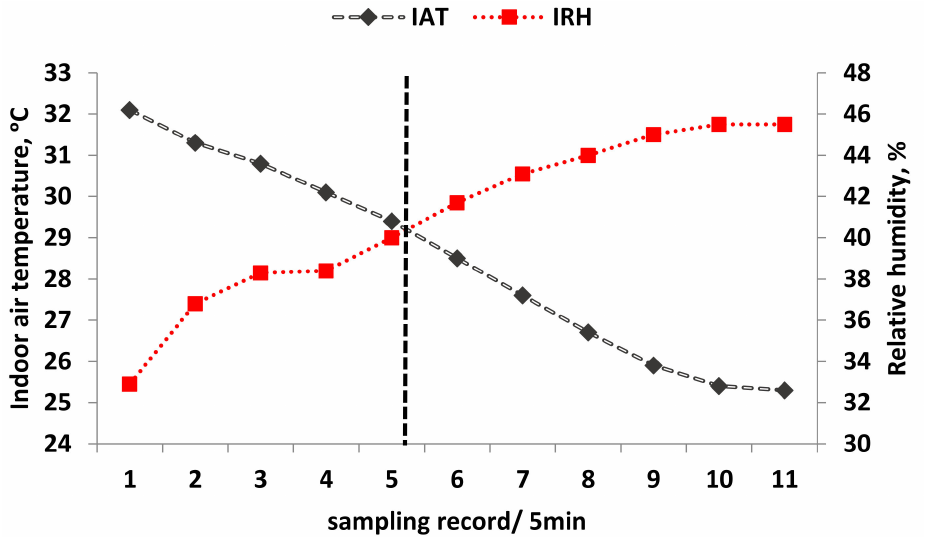
Figure 12. Frequency of reduction in indoor temperature with use of evaporative cooling in sampling record every 5 min, where IAT is indoor air temperature and IRH is indoor relative